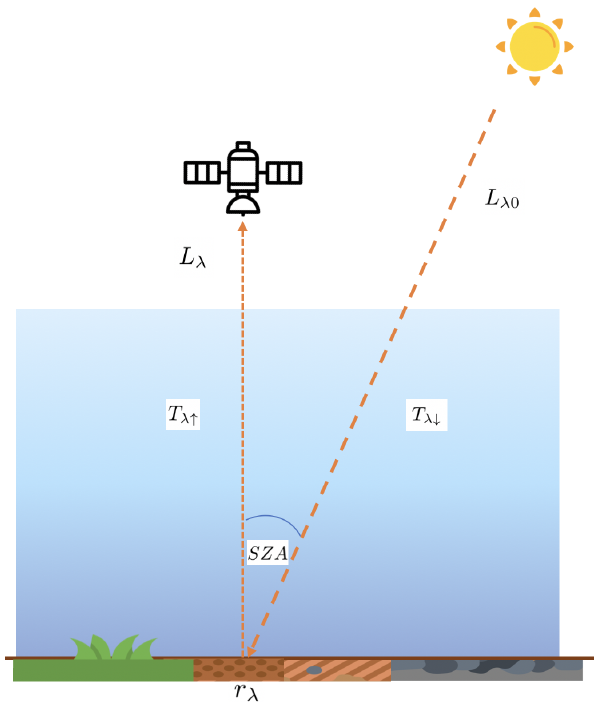
Figure 2. A schematic for reflected sunlight from the Sun through the atmosphere to a spectrometer in